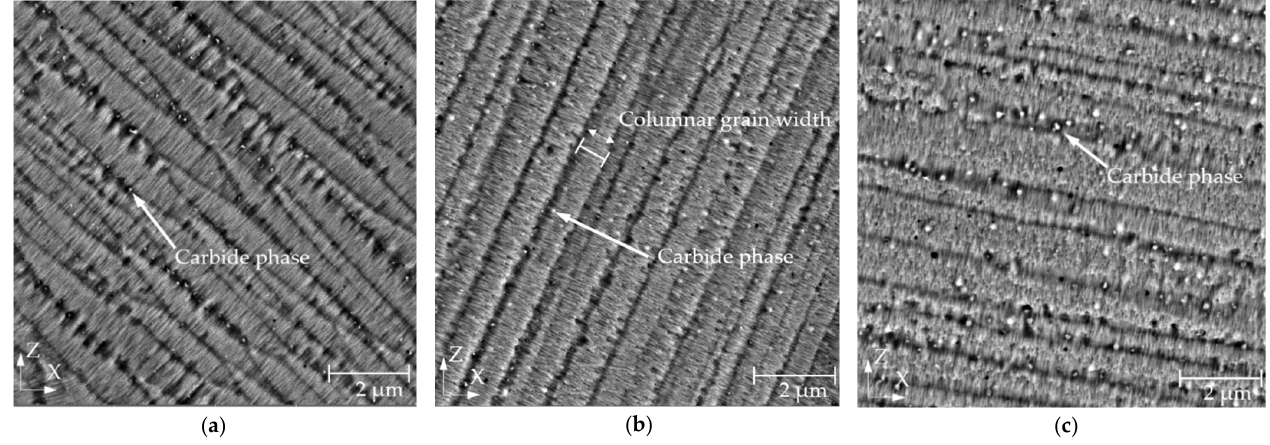
Figure 6. SEM-BSE microstructure of IN939 specimens fabricated at different preheating temperatures showing a gradual increase of the size and amount of the carbide phase (white dots). ( a ) XZ plane of the RT specimen; ( b ) XZ plane of the specimen with a base plate preheated at 200 °C; ( c ) XZ plane of the specimen with a base plate preheated at 400 °C.